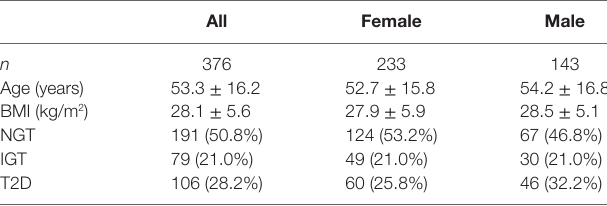
TaBle 1 | Composition of the study cohort included in zonulin measurements. all